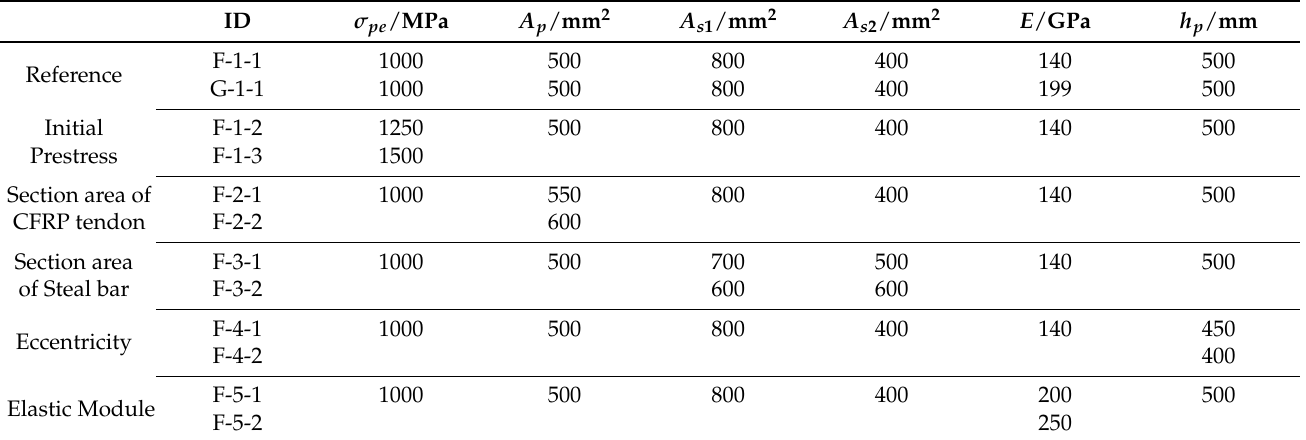
Table 4. Main variables of simulated